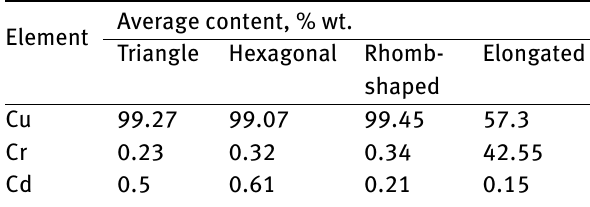
Table 2: Chemical analysis of particles Average content, % wt. Element